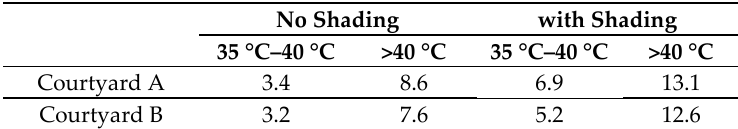
Table 1. Maximum thermal gap in the courtyards.